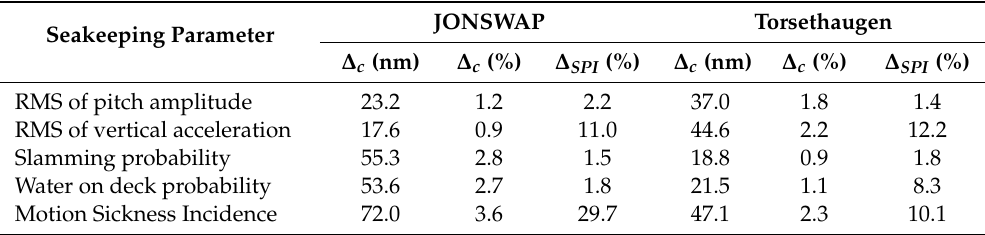
Table 6. Sensitivity analysis, 7-day, F N =